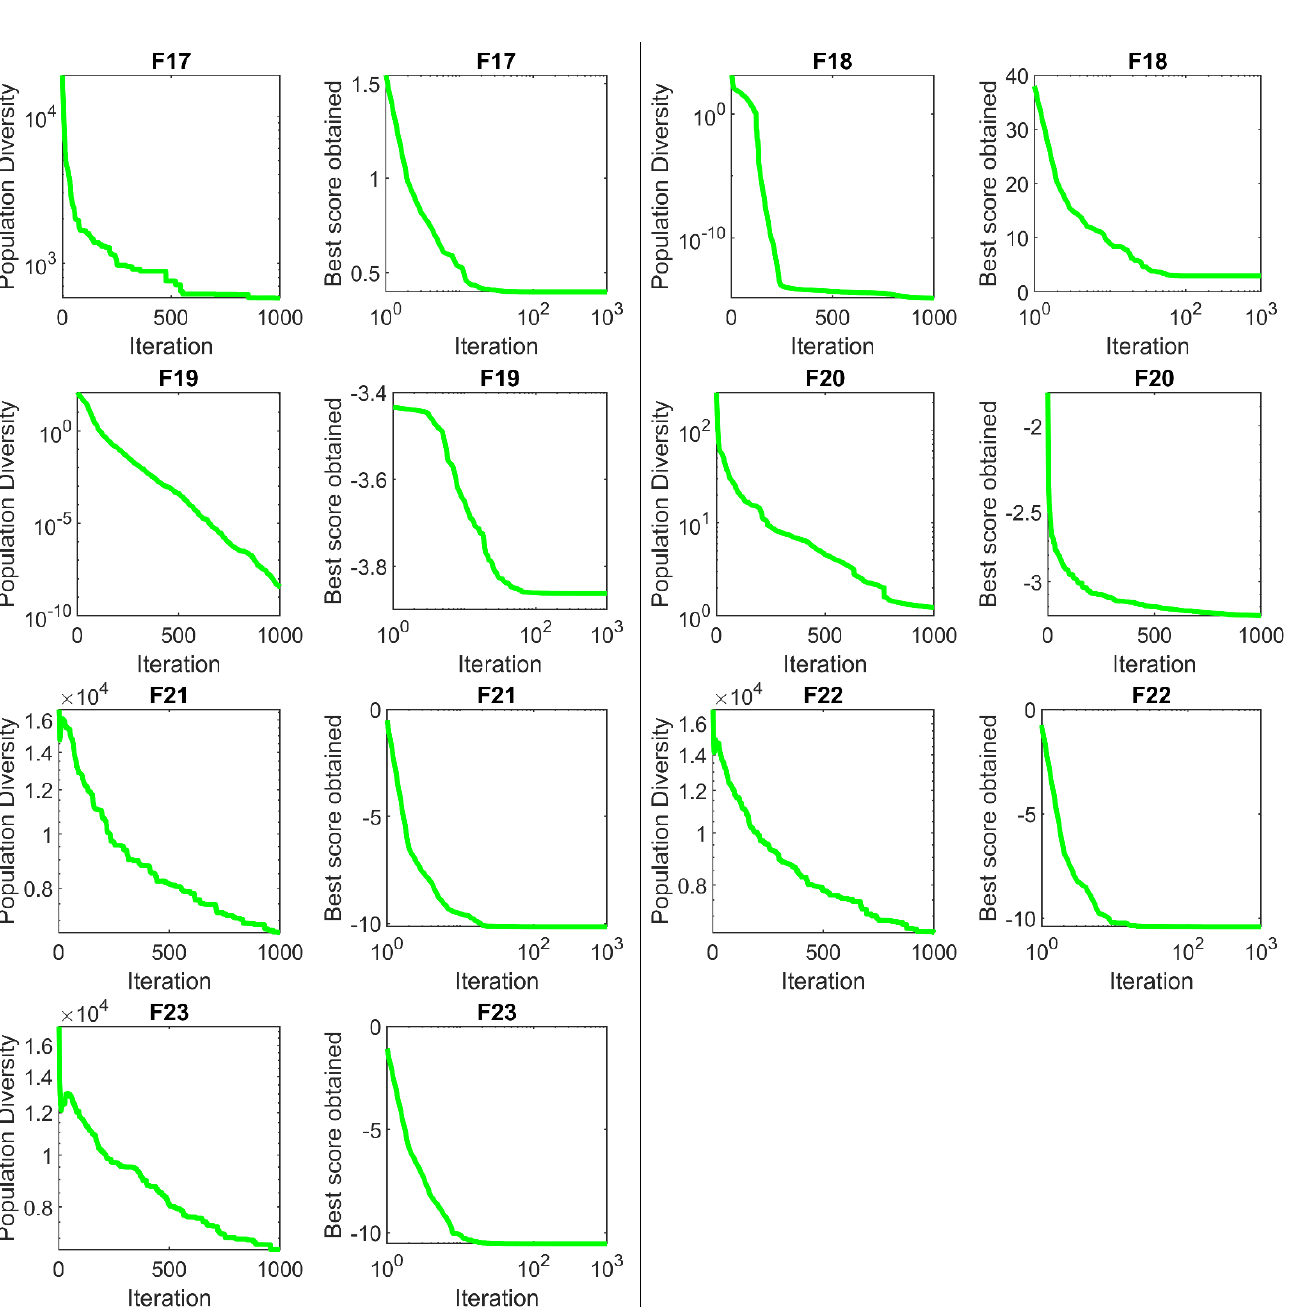
Figure 7. The population diversity and convergence curves of the SSVUBA.